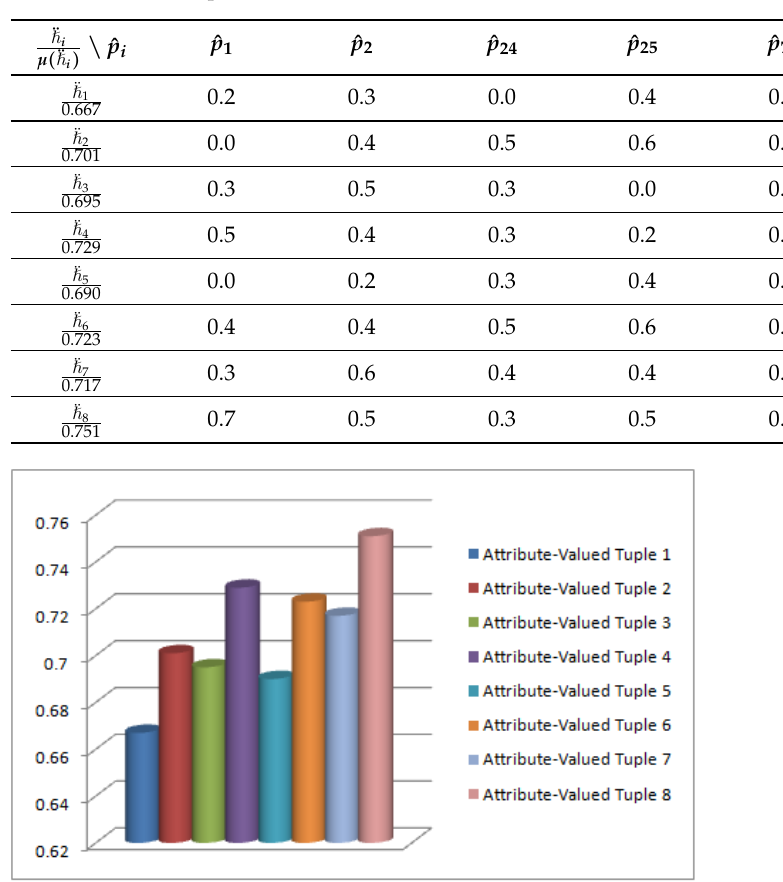
Table 6. Tabular Representation of ∆ -set S ∆ .